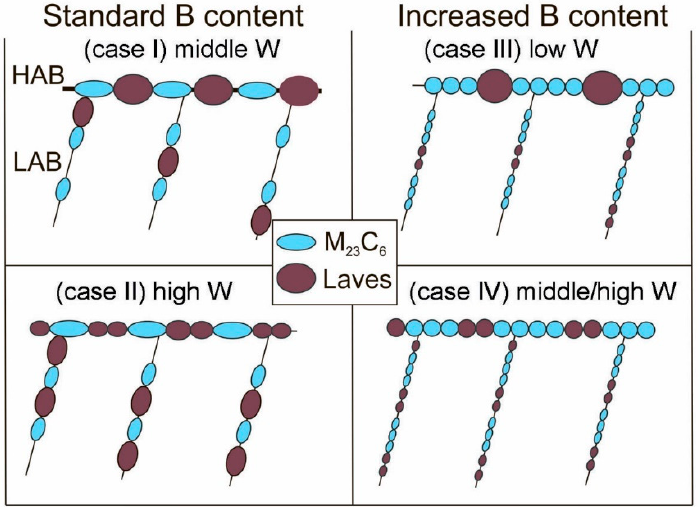
Figure 10. Scheme describing the difference in the nucleation of Laves phase in the 9–10%Cr steels with standard B content (0.005% B) and high B content (0.008–0.012% B) and different W content (1.5–3%).